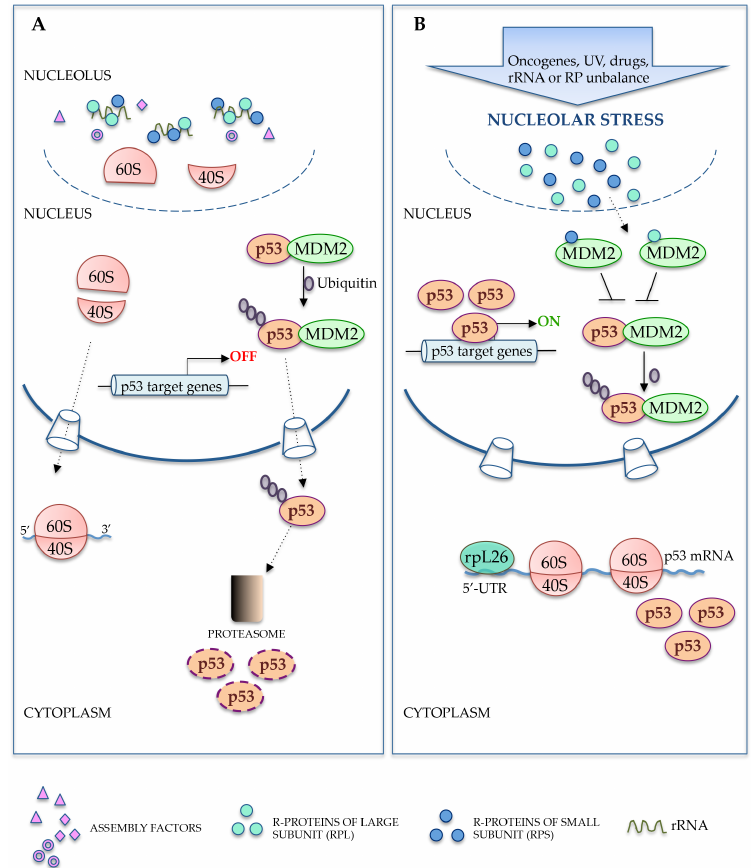
Figure 2. Role of ribosomal proteins in p53 activation upon nucleolar stress. ( A ) Under normal growth conditions, r-proteins are assembled with processed rRNA into 40S and 60S subunits in the nucleolus. p53 activity is maintained at low levels by its degradation promoted by mouse double minute (MDM2)-mediated ubiquitinylation; ( B ) During nucleolar stress, r-proteins are released into the nucleoplasm where they interact with MDM2 inhibiting its ubiquitin ligase activity and promoting the accumulation of p53. In the cytoplasm, ribosome-free rpL26 binds to 5 (cid:48) -untranslated region (UTR) of p53 mRNA to induce p53 translation. Accumulated p53 activates the expression of its target genes involved in the activation of events leading to cell cycle arrest and